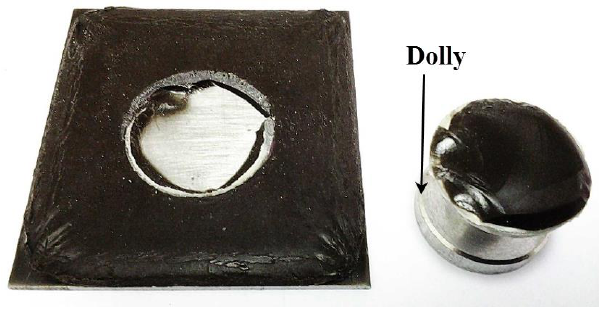
Figure 1. Sample that has undergone adhesive failure.